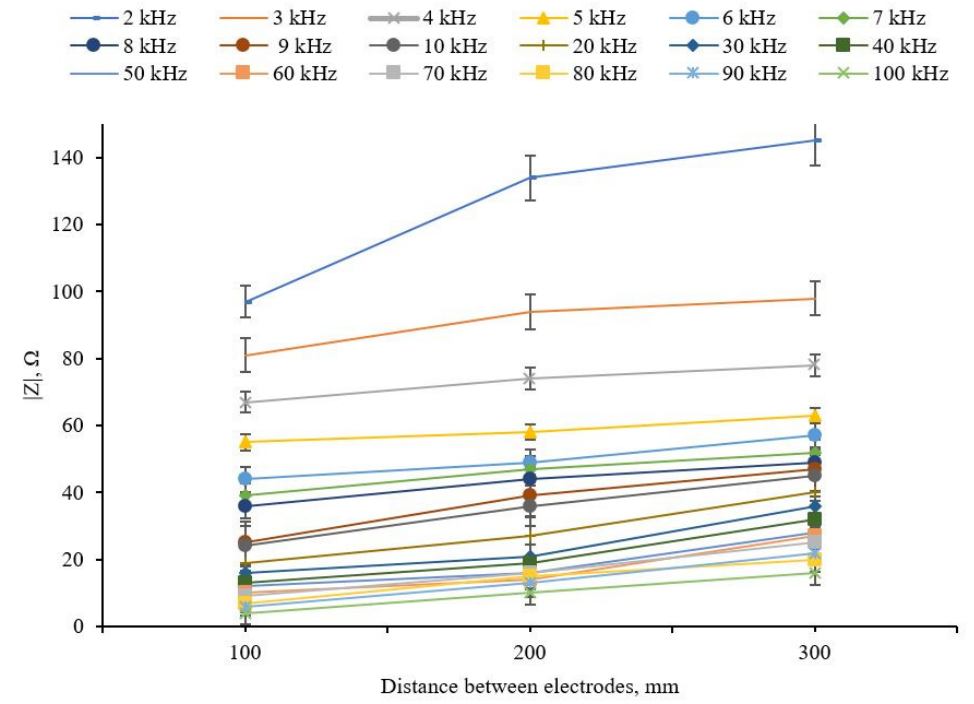
Figure 5. Dependence of the impedance modulus on the distance between the electrodes at different frequencies after compensation of the parasitic capacitance (for a pear tree 13 mm in diameter).